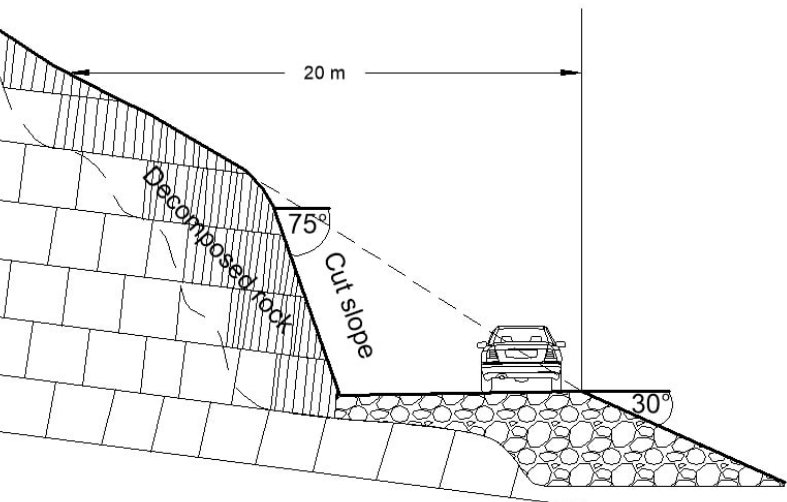
Figure 3. Schematic profile to illustrate the underestimated slope values at road cuts in the Harz mountains. The steep-cut slope is not resolved in the elevation model of 20 m. Table 2. Engineering-geological characterization of materials in the Harz mountains [32]. Where categories are merged, the ground types are displayed in